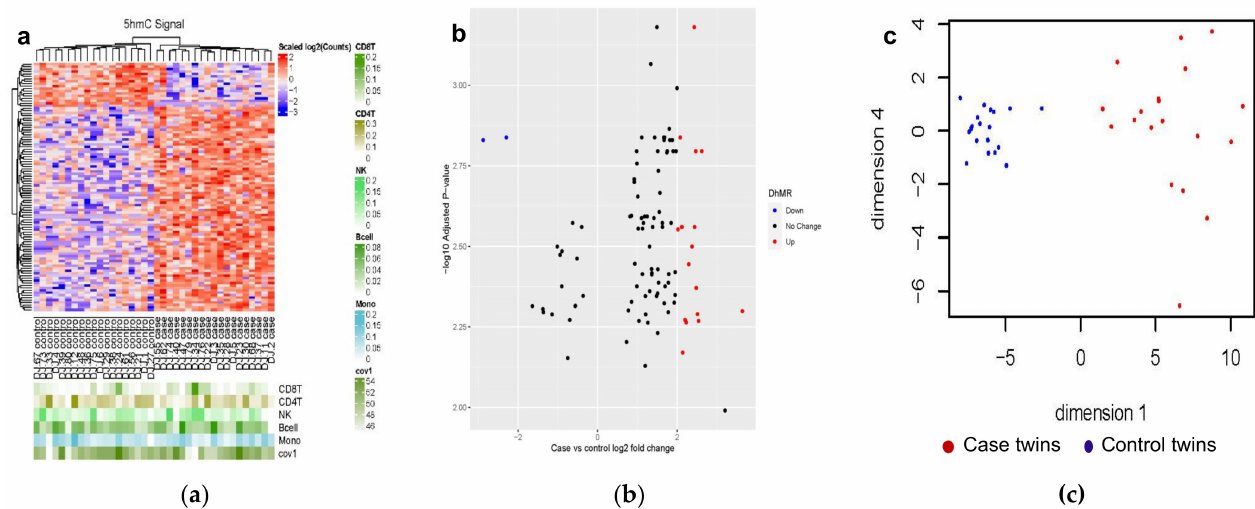
Figure 1. Graph-based visualization of the 102 candidate differentially hydroxymethylated regions (DhMRs) among 19 monozygotic twin pairs discordant for cardiovascular death. ( a ). Heatmap. Abbreviation: CD8T = CD8+ T-cells; CD4T = CD4+ T-cells; NK = natural killer cells; Bcel = B-cells; Mono = monocytes; Cov1 = age; 5hmC = 5-hydroxymethylcytosine. Each row represents a DhMR, and each column represents a participant. The normalized count values are log 2 transformed and then scaled with z-score in the blue-red color scale. The 102 DhMRs were adjusted for leukocyte subtypes and age. The lower level of hydroxymethylation among co-twins than their twin brothers is in blue, and the higher level of hydroxymethylation than their twin brothers is in red; ( b ). volcano plot. The horizontal axis represents the log 2 fold-change (FC) (case versus control twins), and the vertical axis corresponds to the negative log 10 (adjusted p -value). Red dots represent the significant ( − log 10 adjusted p -value > 2.0) hyper-DhMRs (log 2 FC > 2) and blue dots represent significant ( − log 10 adjusted p -value > 2.0) hypo-DhMRs (log 2 FC < − 2) when comparing cases with their corresponding control co-twins; and ( c ). scatter plot. The overall effect of the 102 DhMRs was represented with principal components (PC) 1 and 4 from principal component analysis. The horizontal axis represents PC1 (i.e., dimension 1), and the vertical axis displays PC4 (i.e., dimension 4). Red dots represent case twins, while blue dots represent their control twin